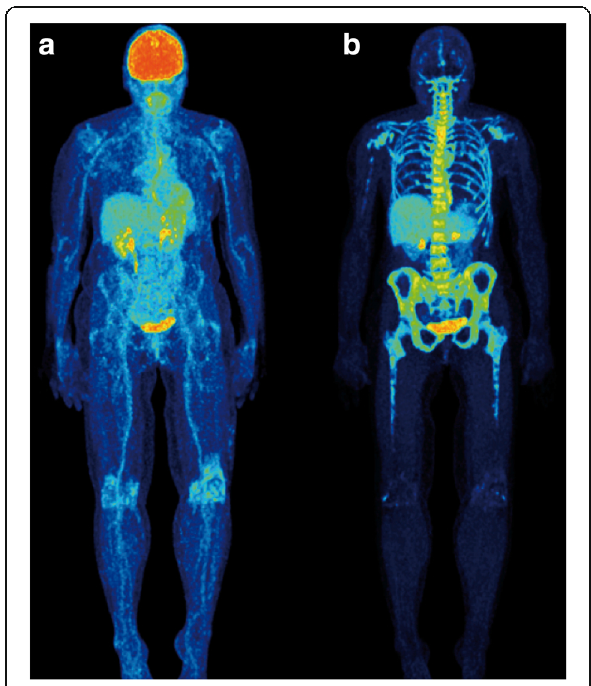
Fig. 2 Maximum intensity projection (MIP) 18 F-FDG PET/CT ( a ) and 18 F-FLT PET/CT ( b ) of a 76-year-old female SMM patient. No focal, myeloma-indicative lesions detected with either tracer. Normal 18 F-FLT distribution is characterized by high background activity by the bone marrow compartment (e.g., vertebral column, pelvic skeleton, proximal femora) reflecting the high proliferative activity of hematopoietic